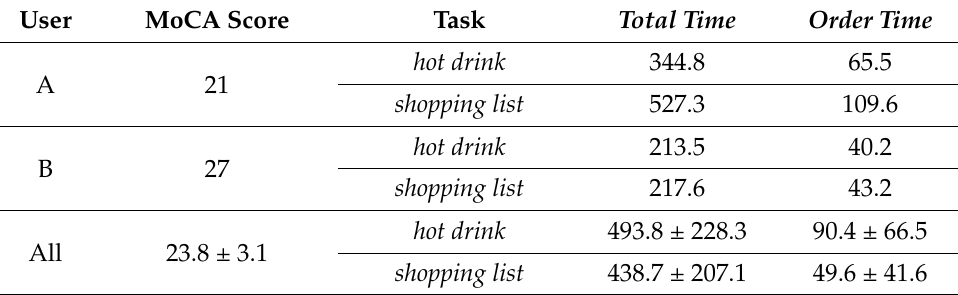
Table 2. Comparison of times (seconds) for case study users and All users.